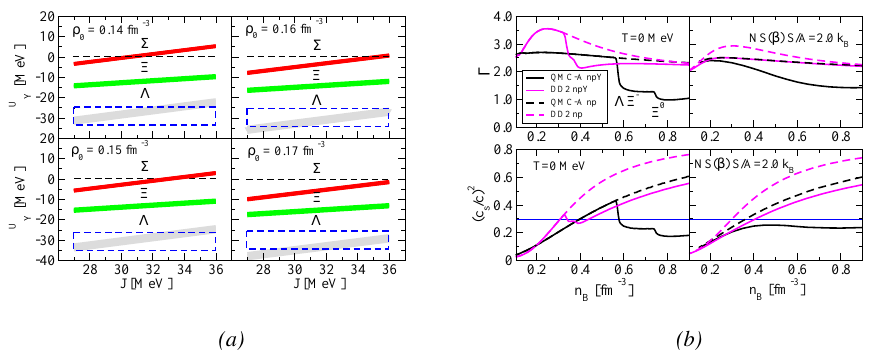
Figure 4: (a) Single-particle potentials U Λ (grey), U Σ (red) and U Ξ (green) as a function of the symmetry energy coe ffi cient J for the saturation densities ρ 0 between 0.14 and 0.17 fm − 3 . The filled width of the rectangles depicting the potentials represents the uncertainty due to the spread in the saturation energy E 0 / A between -15.0 and -18 MeV. The dashed blue rectangle around U Λ represents the region of experimental values reported in the literature. The horizontal black dashed line guides the eye to zero, dividing positive and negative values of U Σ . No established experimental constraint on U Ξ is available. Taken from Ref. [3] under Creative Commons Attribution License. (b) The adiabatic index Γ and the square of speed of sound in units of c for T = 0 MeV (left top and bottom) and for NS( β ) (top and bottom right). Predictions of the QMC-A model (black) and the DD2 model (green) are shown, both for npY (solid) and np (dashed) matter. The blue horizontal line indicates the conformal limit ( c s / c ) 2 = 1 / 3. The figure is adopted from